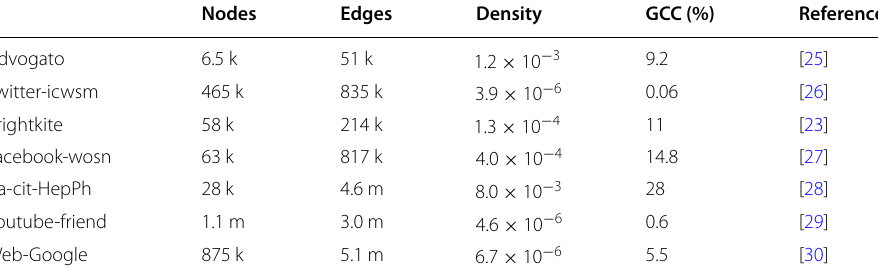
Table 2 Test graph data for comparing outlier edge detection Algorithms Nodes